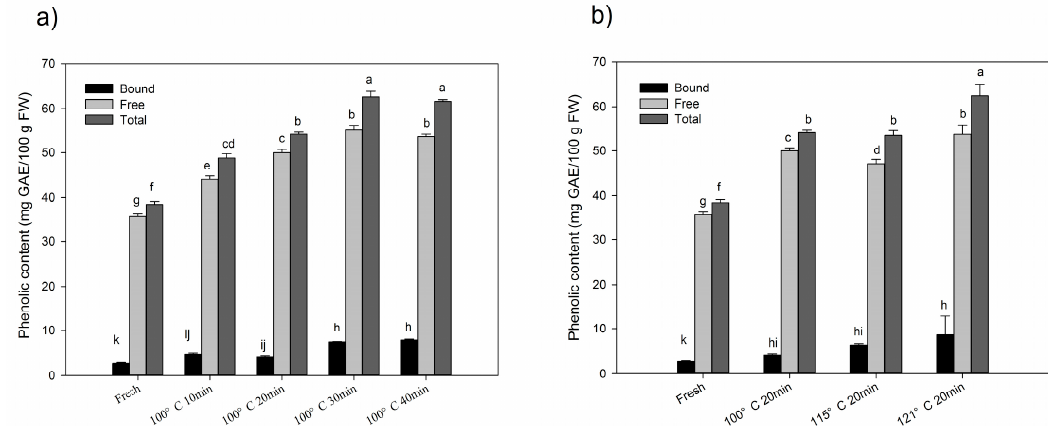
Figure 1. ( a ) Changes of phenolic contents with time-kinetics manner at 100 °C; ( b ) changes of phenolic contents with a thermal gradient manner at 20 min steaming processing. Significant